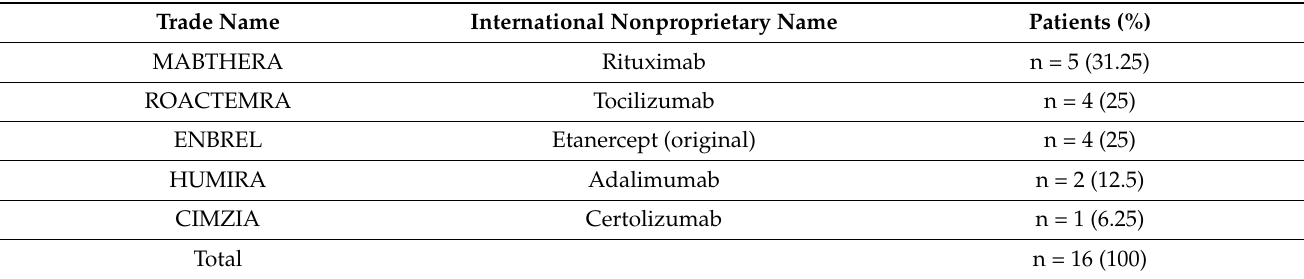
Table 4. Distribution of RA patients with positive QFT test result depending on the biological therapy.